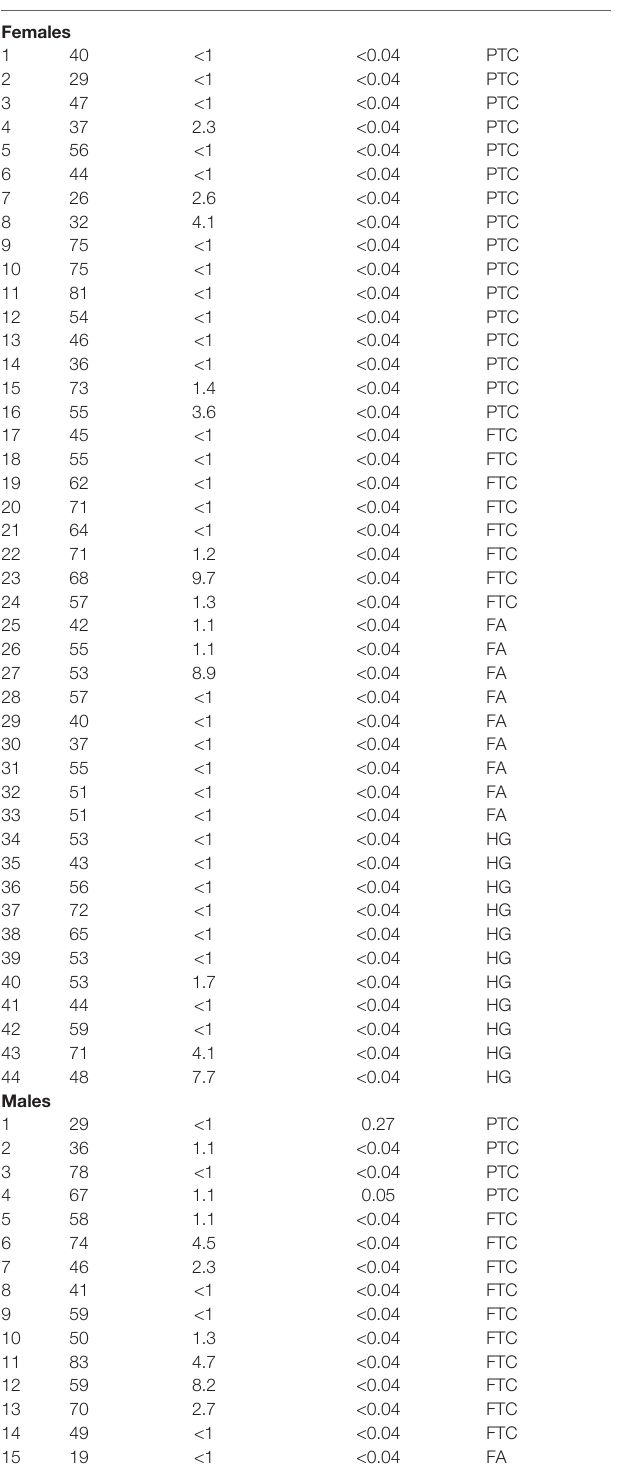
( Table 5 ). None of the non-MTC patients ’ sproCt peaked over